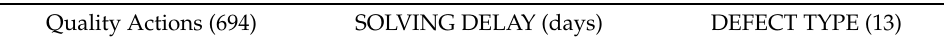
Table 9. Information for each quality action in